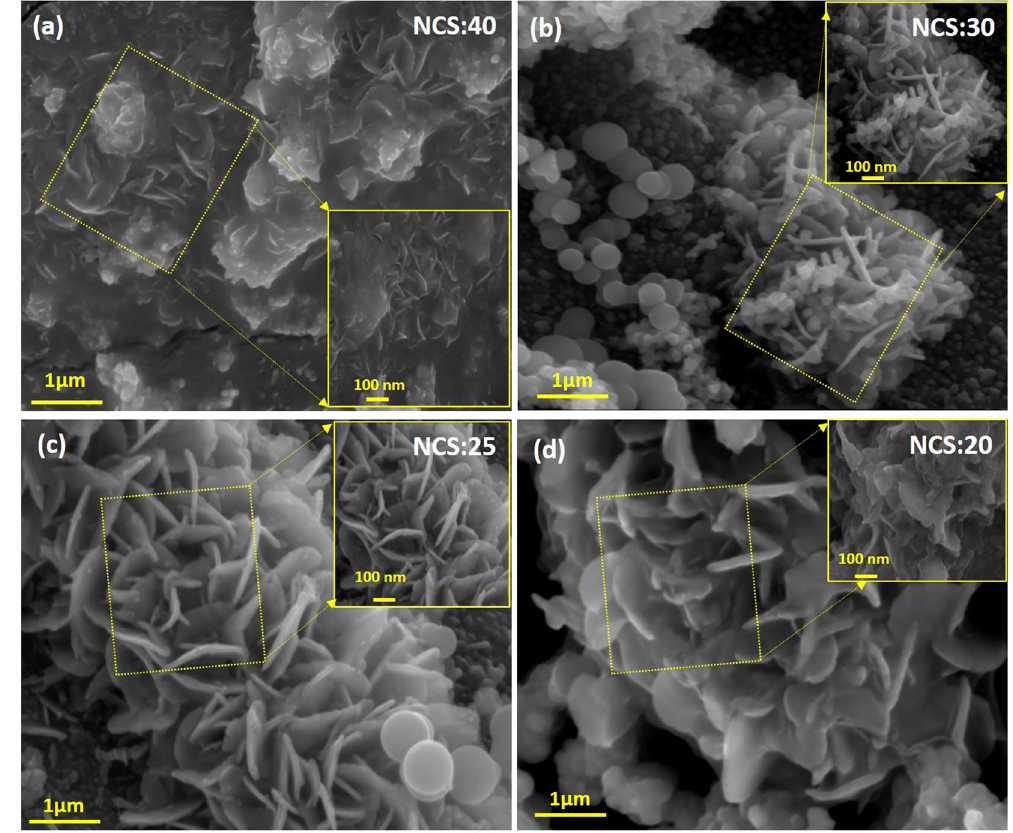
Figure 3. ( a – d ) FE-SEM images of NiCo 2 S 4 thin films prepared for different volume ratios of Ni and Co, like- 40:10, 30:20, 25:25, and 20:30, on Ni mesh, respectively and inset show the high magnification of all